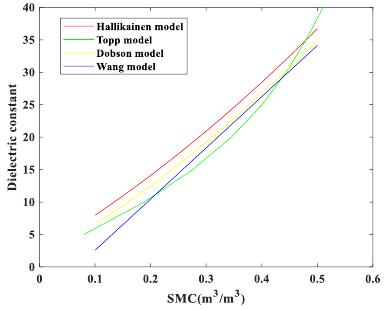
Figure 14 . The four soil models on Kachinsky heavy loam （ C=0.45 ， S=0.55 ）